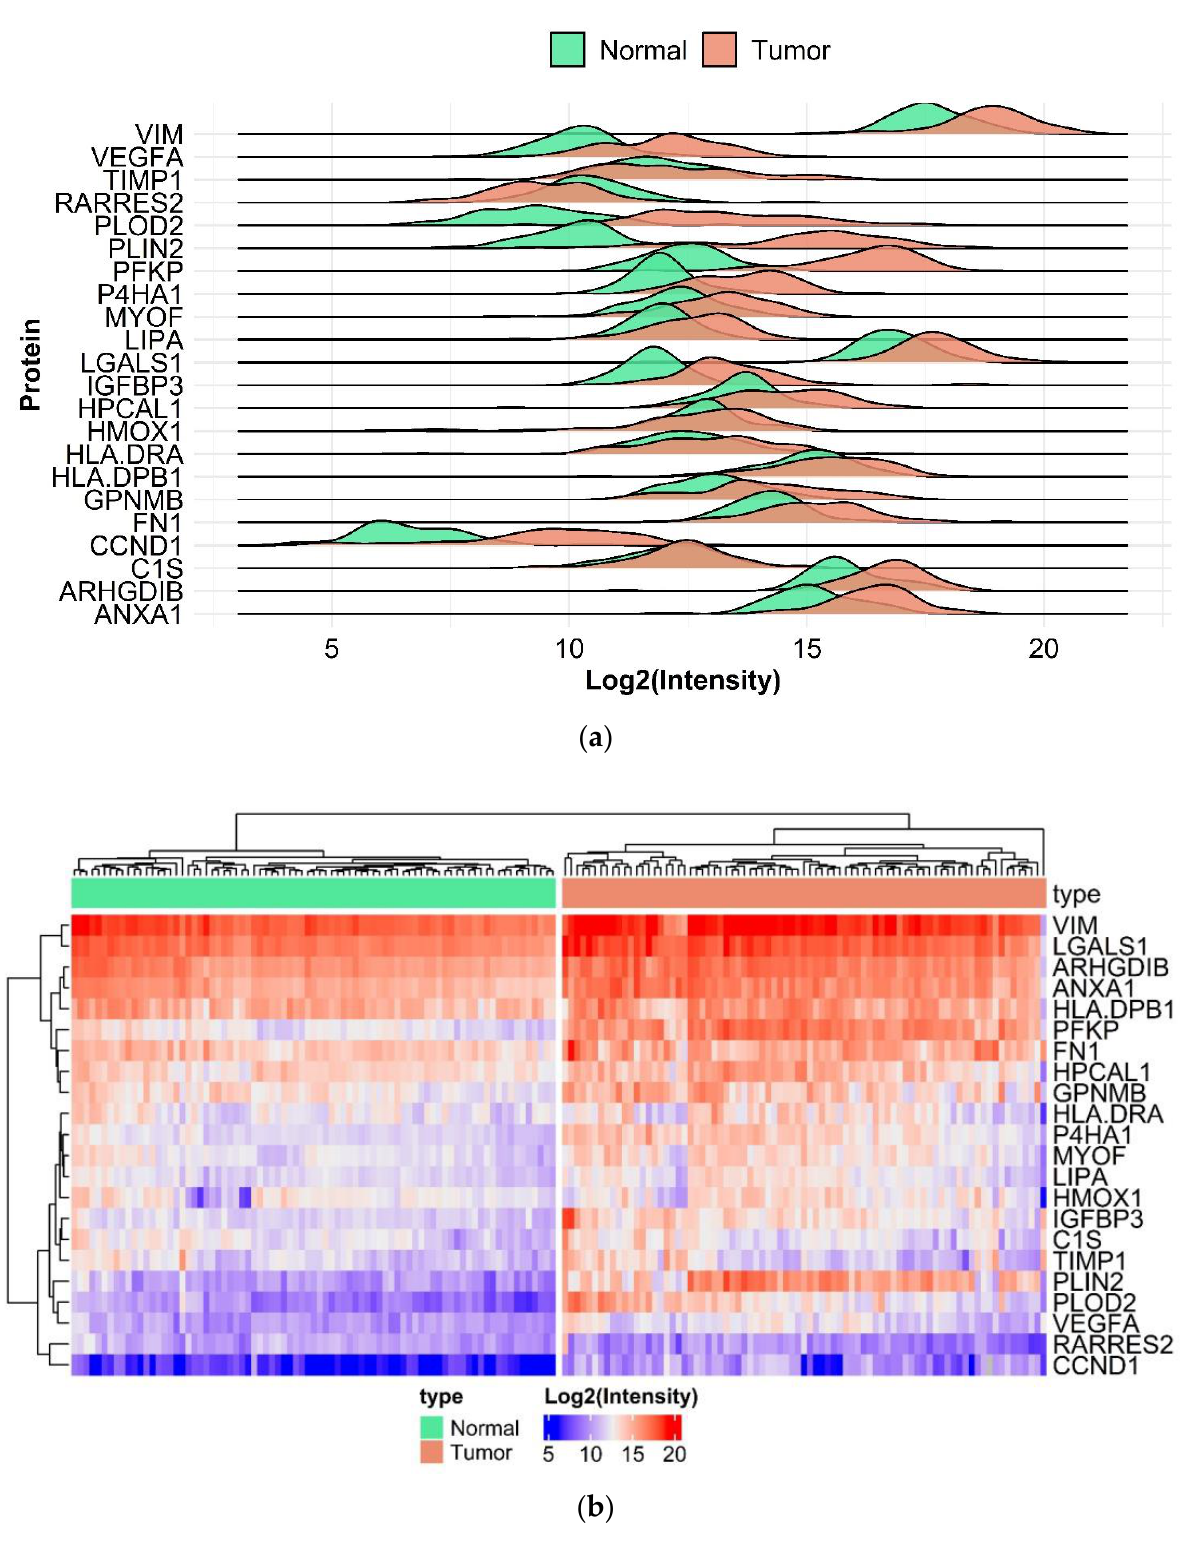
Figure 3. Differential protein abundances of compared normal and ccRCC tumor samples. Ridge plots of differentially expressed proteins shows the distribution of log2 intensity values ( a ). Heatmap of log2 intensity values ( b ).